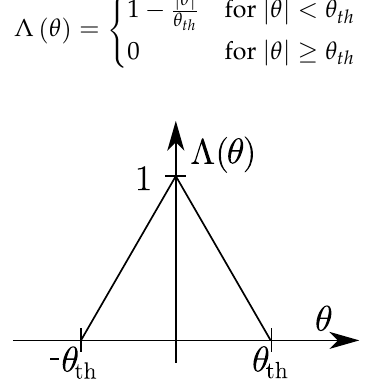
Figure 6. Example of triangle function Λ = Λ ( θ )